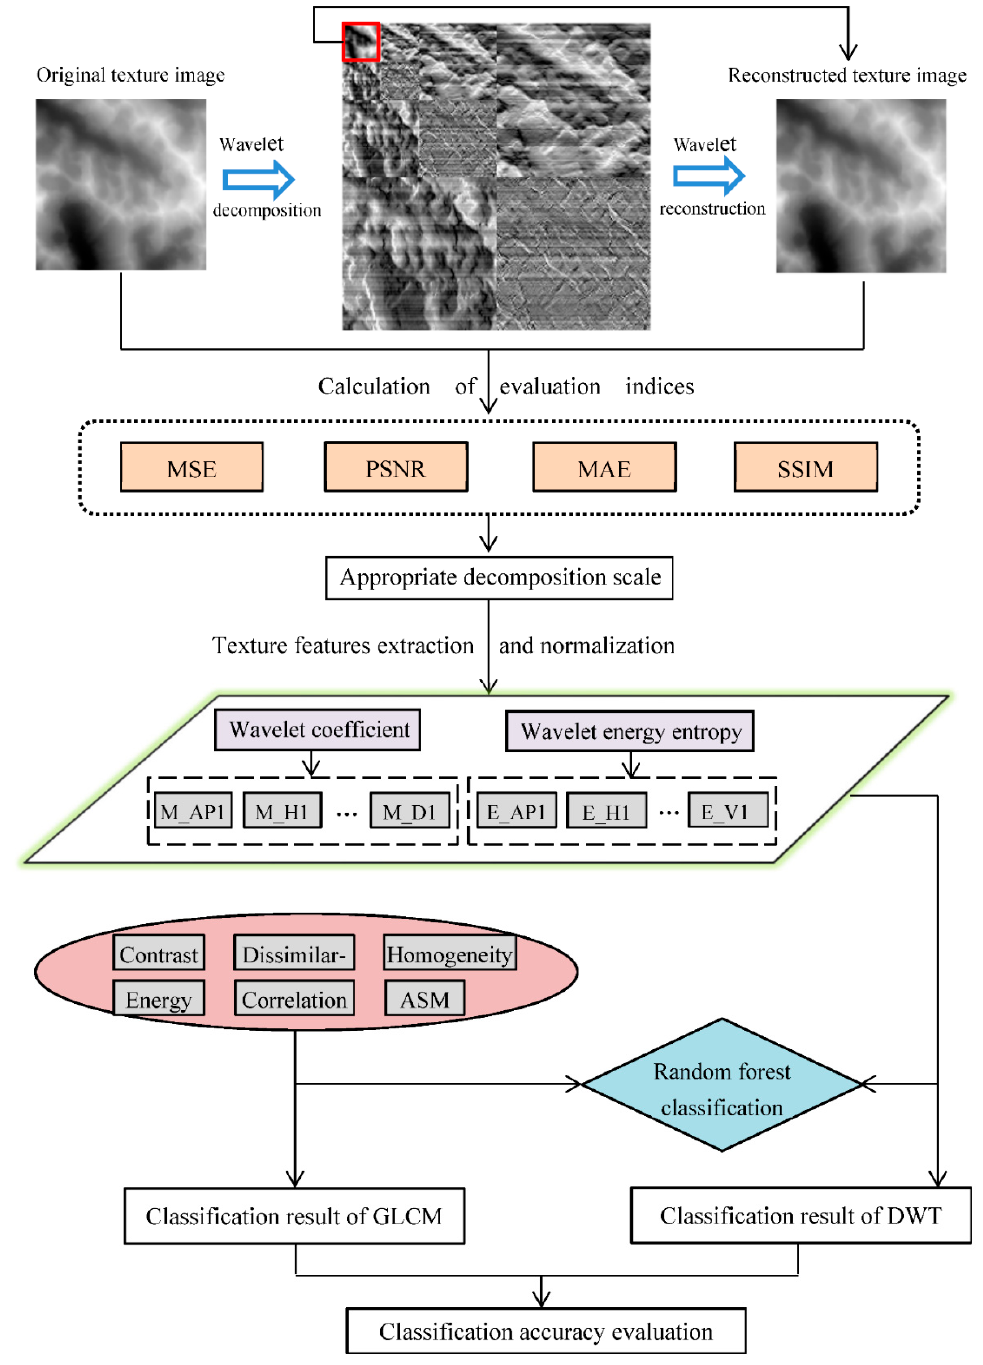
Figure 3. The specific technical route (detailed information of MSE, PSNR, MAE, and SSIM can be seen in Section 2.2.2; discrete wavelet transform (DWT)).